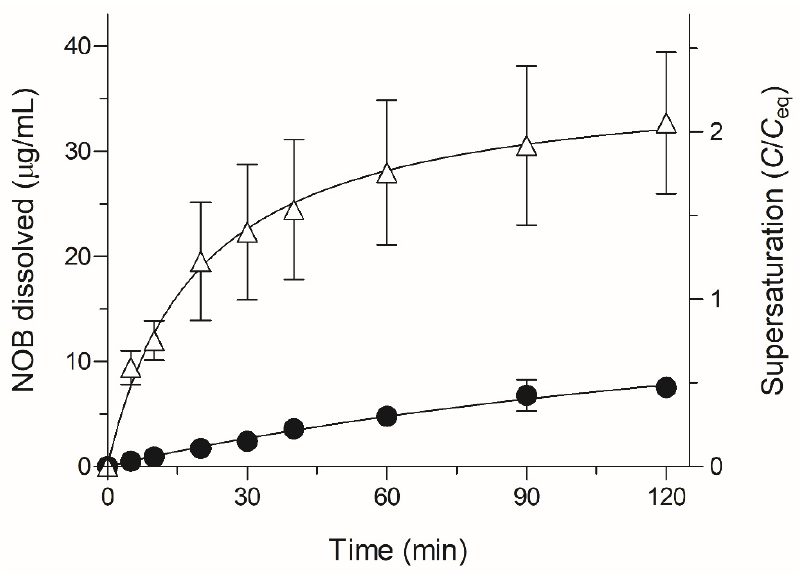
Figure 3. Dissolution profiles of NOB samples in distilled water. ● , Crystalline NOB; △ , ASD/NOB. Each bar represents the mean ± SD of three independent experiments.